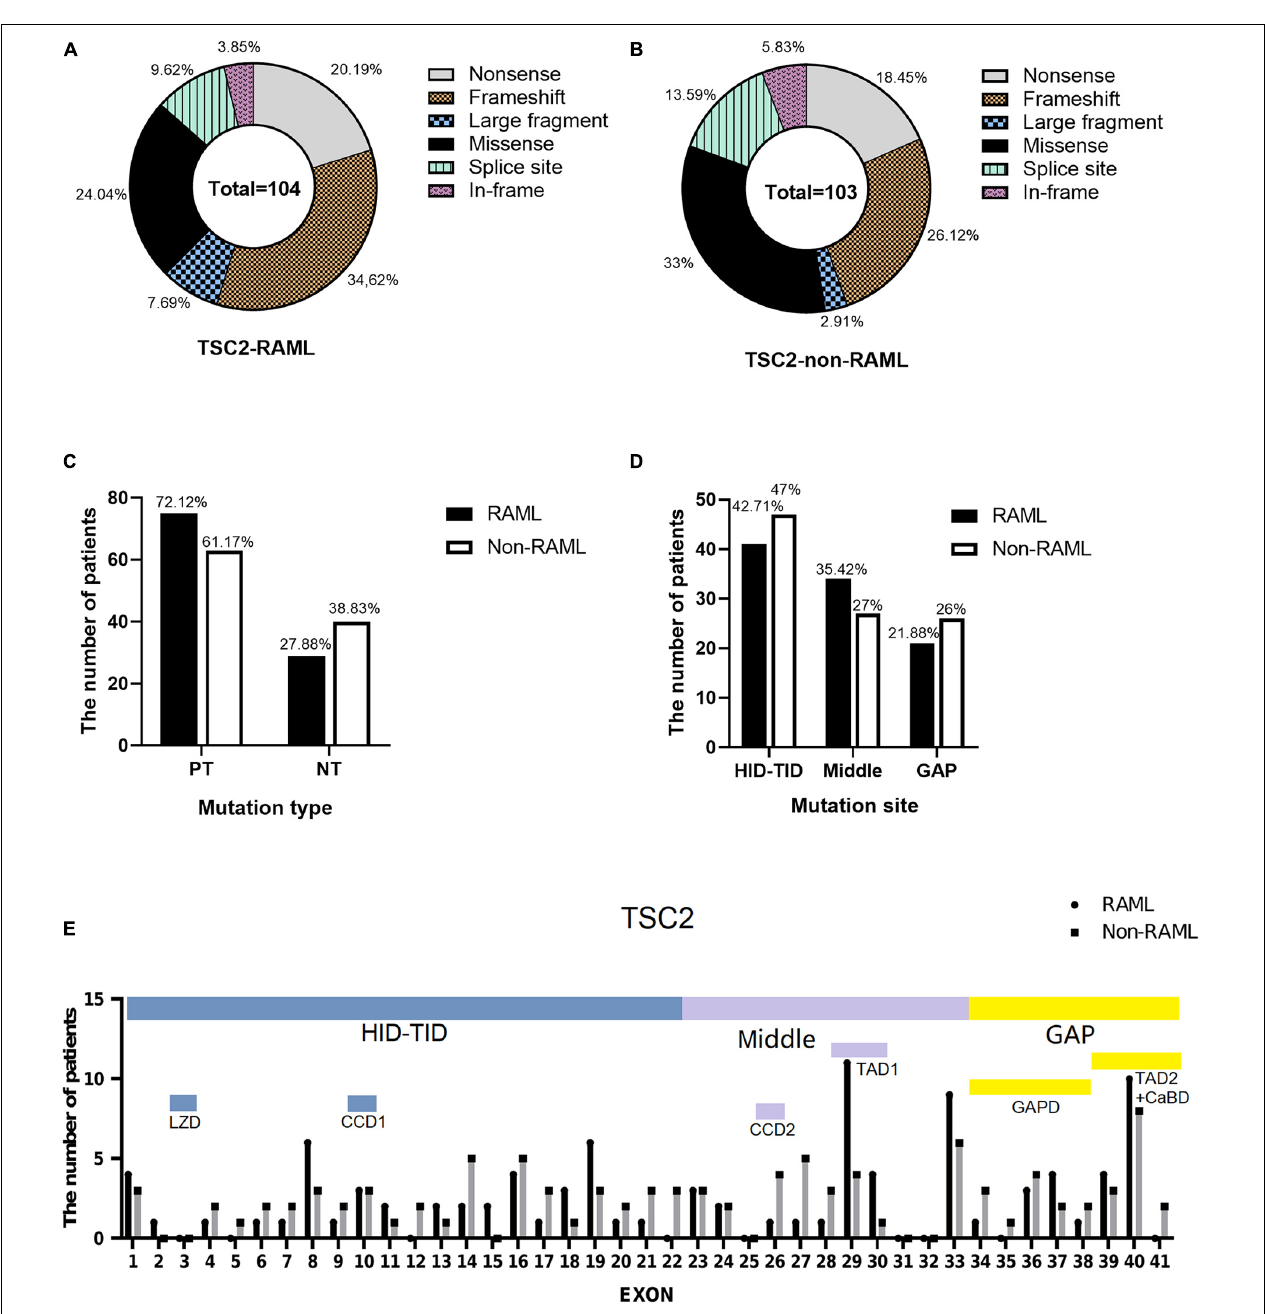
FIGURE 3 | Types and distribution sites of TSC2 gene mutations. (A) Mutation types of TSC2 gene mutation in patients with RAML. (B) Mutation types of TSC2 gene mutation in patients without RAML. (C) The relationship between TSC2 protein truncation mutation (PT) and protein non-truncation mutation (NT) and RAML. (D) The relationship between gene mutation affected or potentially affected HID-TID, middle region, GAP domain and RAML. (E) The distribution of TSC2 mutation sites in patients with or without RAML. HID-TID is encoded by exons 1–22, GAP domain is encoded by exons 34–41, and middle mutations between the two regions were encoded by exons 23–33. Leucine zipper domain (LZD) is encoded by exon 3, coiled coil domain 1 (CCD1) is encoded by exon 10, coiled coil domain 2 (CCD2) is encoded by exon 26, transcription activation domain 1 (TAD1) is encoded by exons 29–30, GTPase activating protein domain (GAPD) is encoded by exons 34–38, transcription activation domain 2 (TAD2) is encoded by exons 39–40 and calmodulin-binding domain (CaBD) is encoded by exons 40–41.